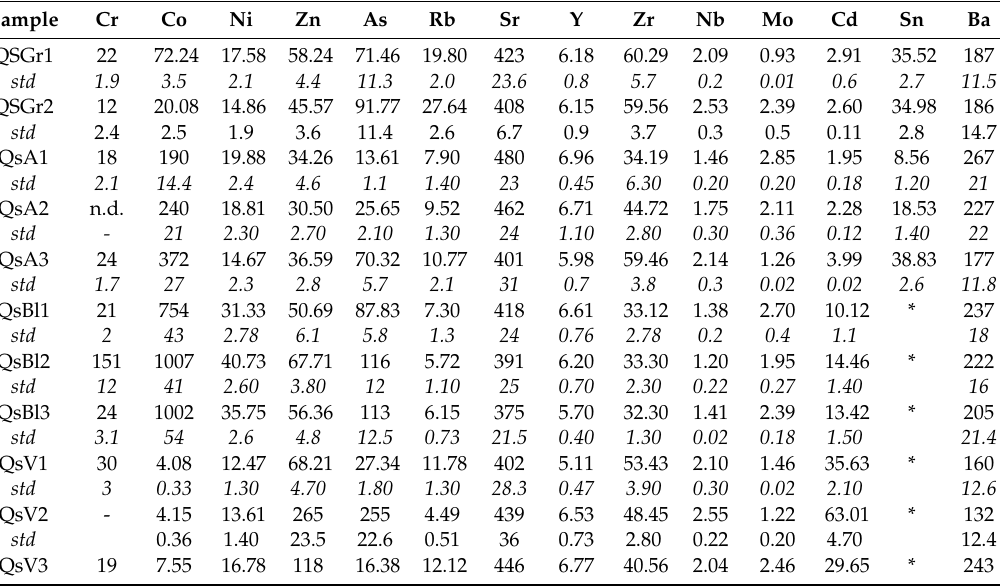
Table 4. Trace element concentrations in ppm determined by